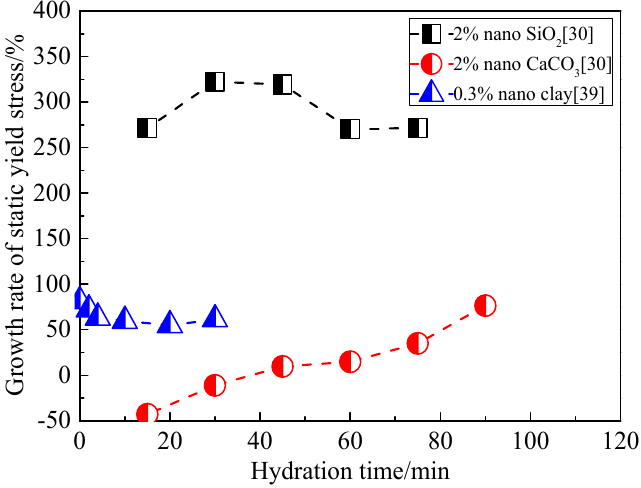
Figure 10. The growth rate of static yield stress of cement pastes with addition of nanoparticles compared with ordinary cement paste [30,39]. compared with ordinary cement paste